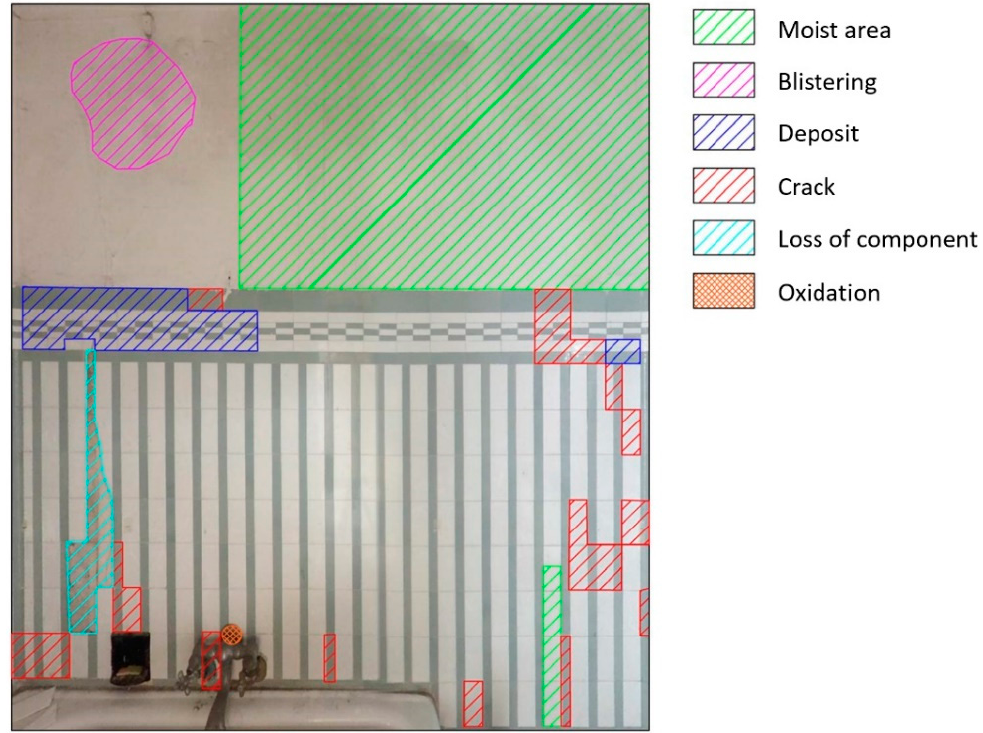
Figure 5. The different deterioration effects identified and mapped on the rectified image. Areas can be easily computed, so that the unary costs associated with each intervention may be used to work out a quotation for wall restoration.